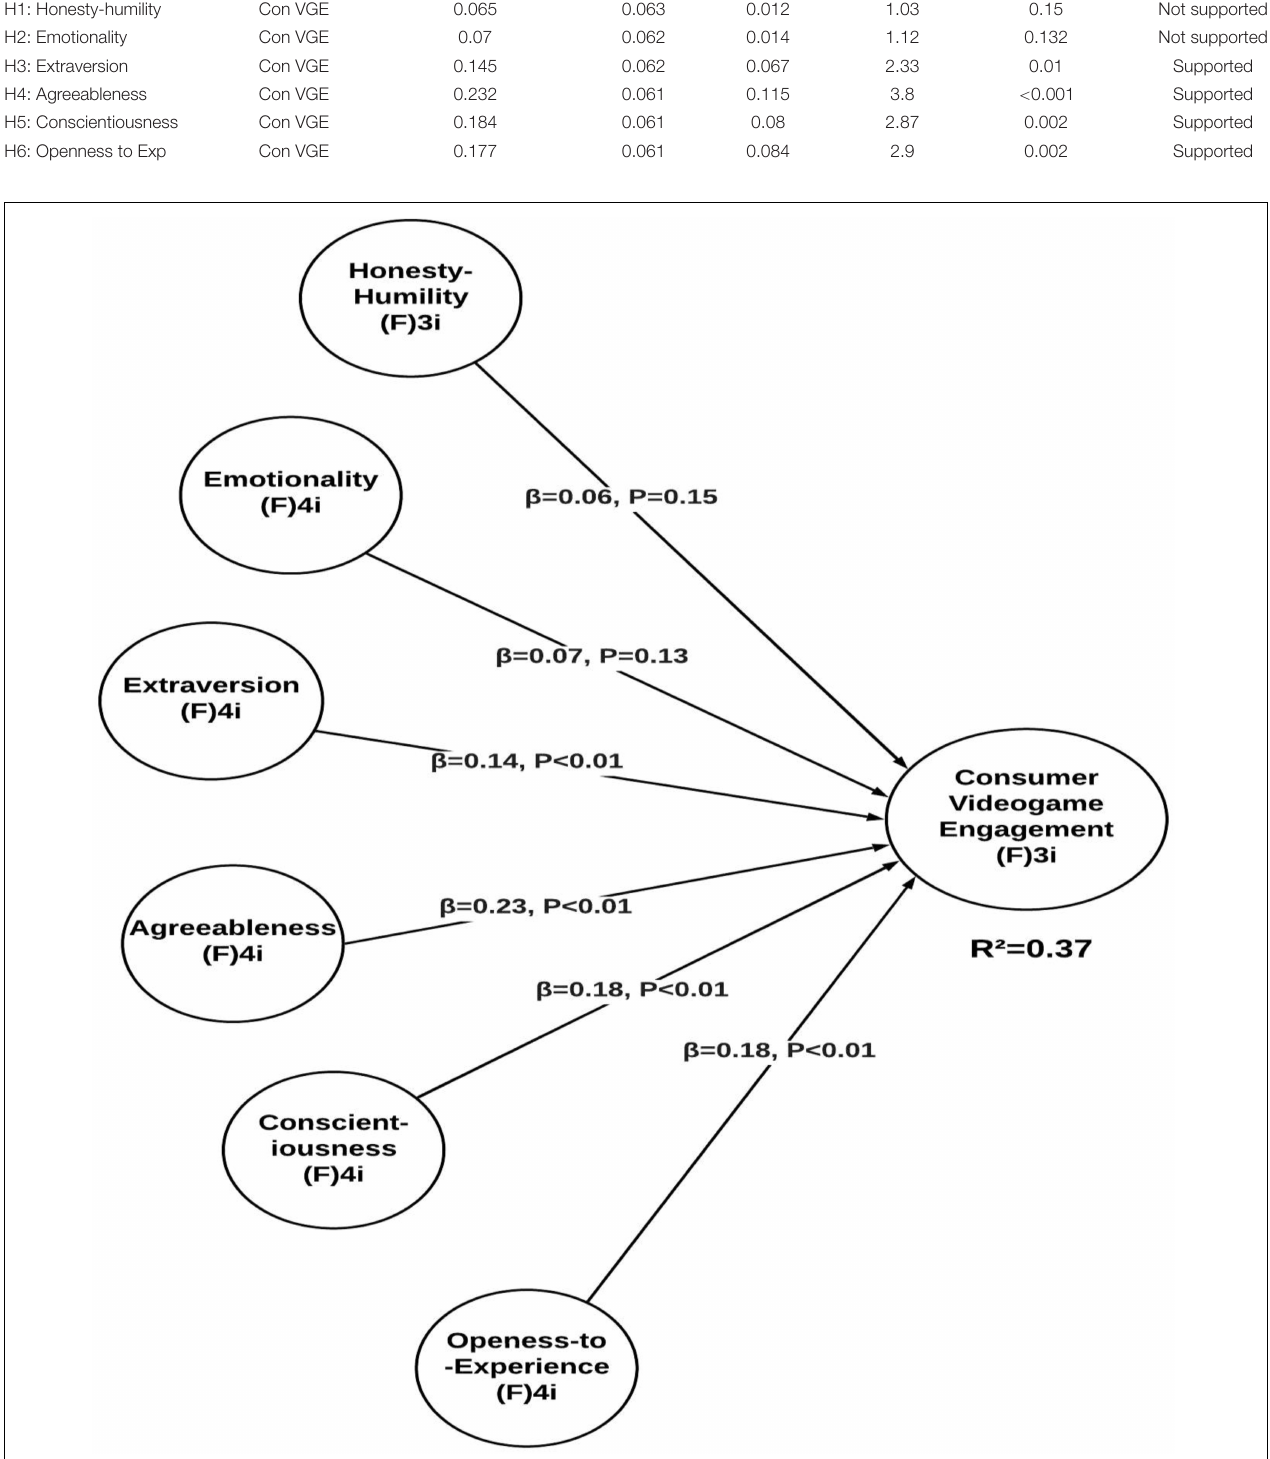
FIGURE 3 | Structural model